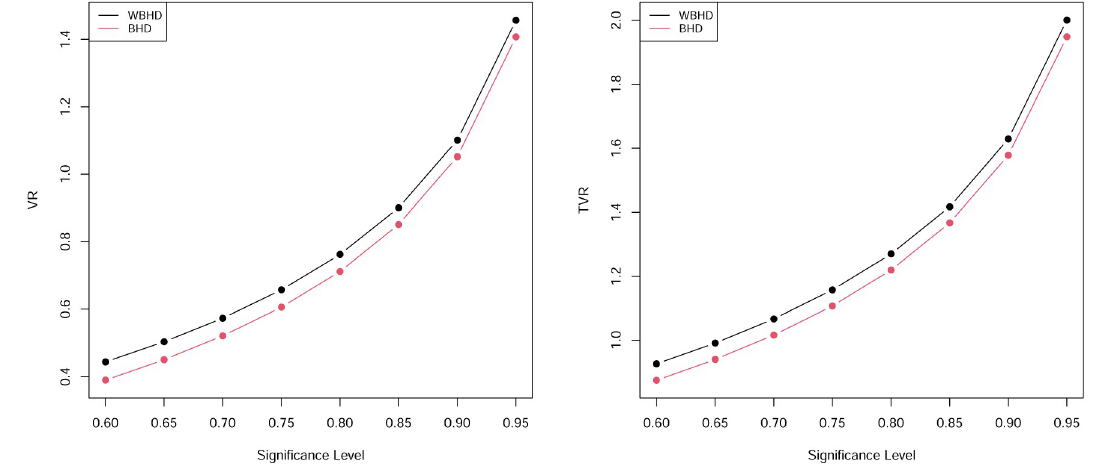
Fig 4. Graphs of the VR and TVR by the values in Table